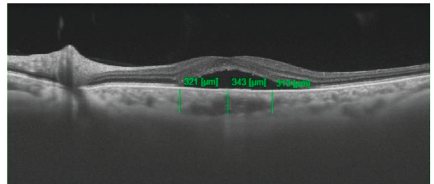
Figure 1: Enhanced-depth imaging (EDI)—OCT demonstrates subfoveal choroidal thickness (SFCT) and choroidal thickness 1500 micrometers temporal and nasal to the fovea.